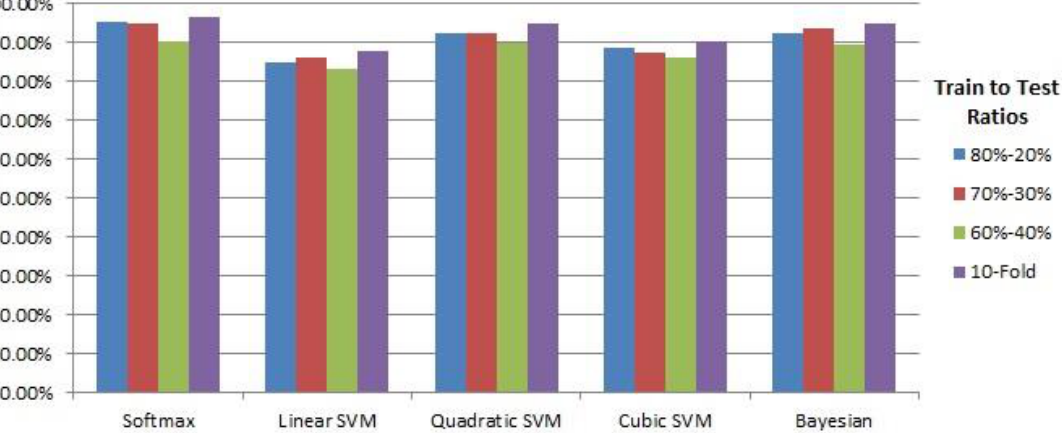
Figure 9. Accuracy results using contrast-enhanced images for various train-to-test ratios of aug- mented dataset.